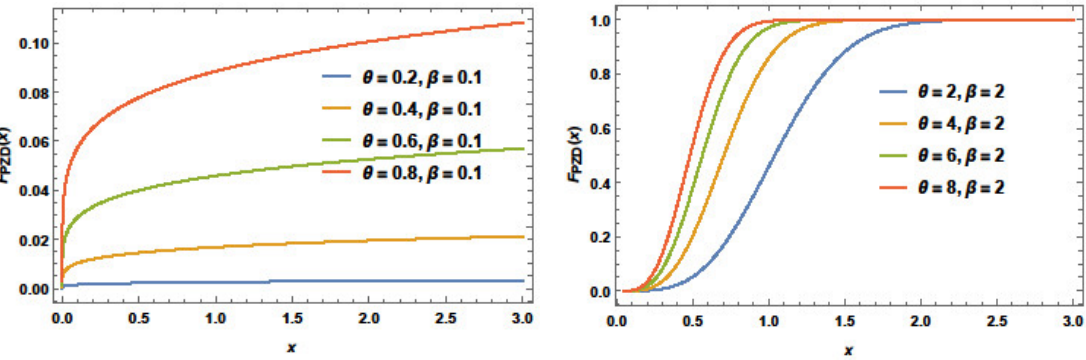
Figure 2. Plots of the cdf of PZD for selected values of β and θ